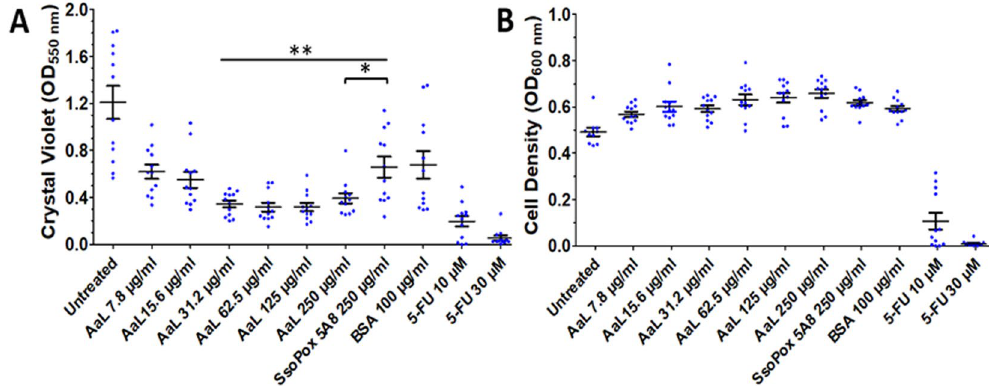
Figure 3. Effect of AaL on biofilm formation by Acinetobacter baumannii ( A ) and cell density ( B ) Biofilm was quantified using crystal violet staining and amount of biofilm is expressed as absorbance (550 nm). The cell density is a measure of cell growth in suspension measured as absorbance at 600 nm. The inactive mutant of the lactonase SsoPox (5A8) containing 10 mutations (V27G/P67Q/L72C/Y97S/Y99A/T177D/R223L/L226Q/ L228M/W263H) and Bovine Serum Albumin (BSA) were used as negative controls while quorum sensing inhibitor (QSI) 5-fluoro-uracil has been used as positive control. Data shown are average of three independent experiments with 4 technical replicates each (n = 12), error bars represent the standard deviation. Student t-test results are shown (A) between data for biofilm formed with different doses of AaL and data for biofilm formed in presence of the inactive lactonase